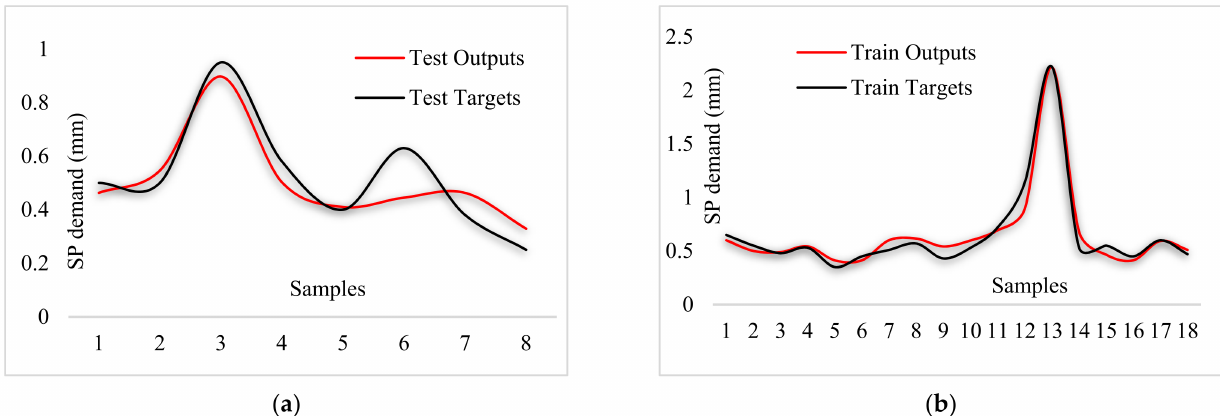
Figure 16. Comparison of outputs and targets for ANFIS-ACO: ( a ) Testing phase, ( b ) training phase.